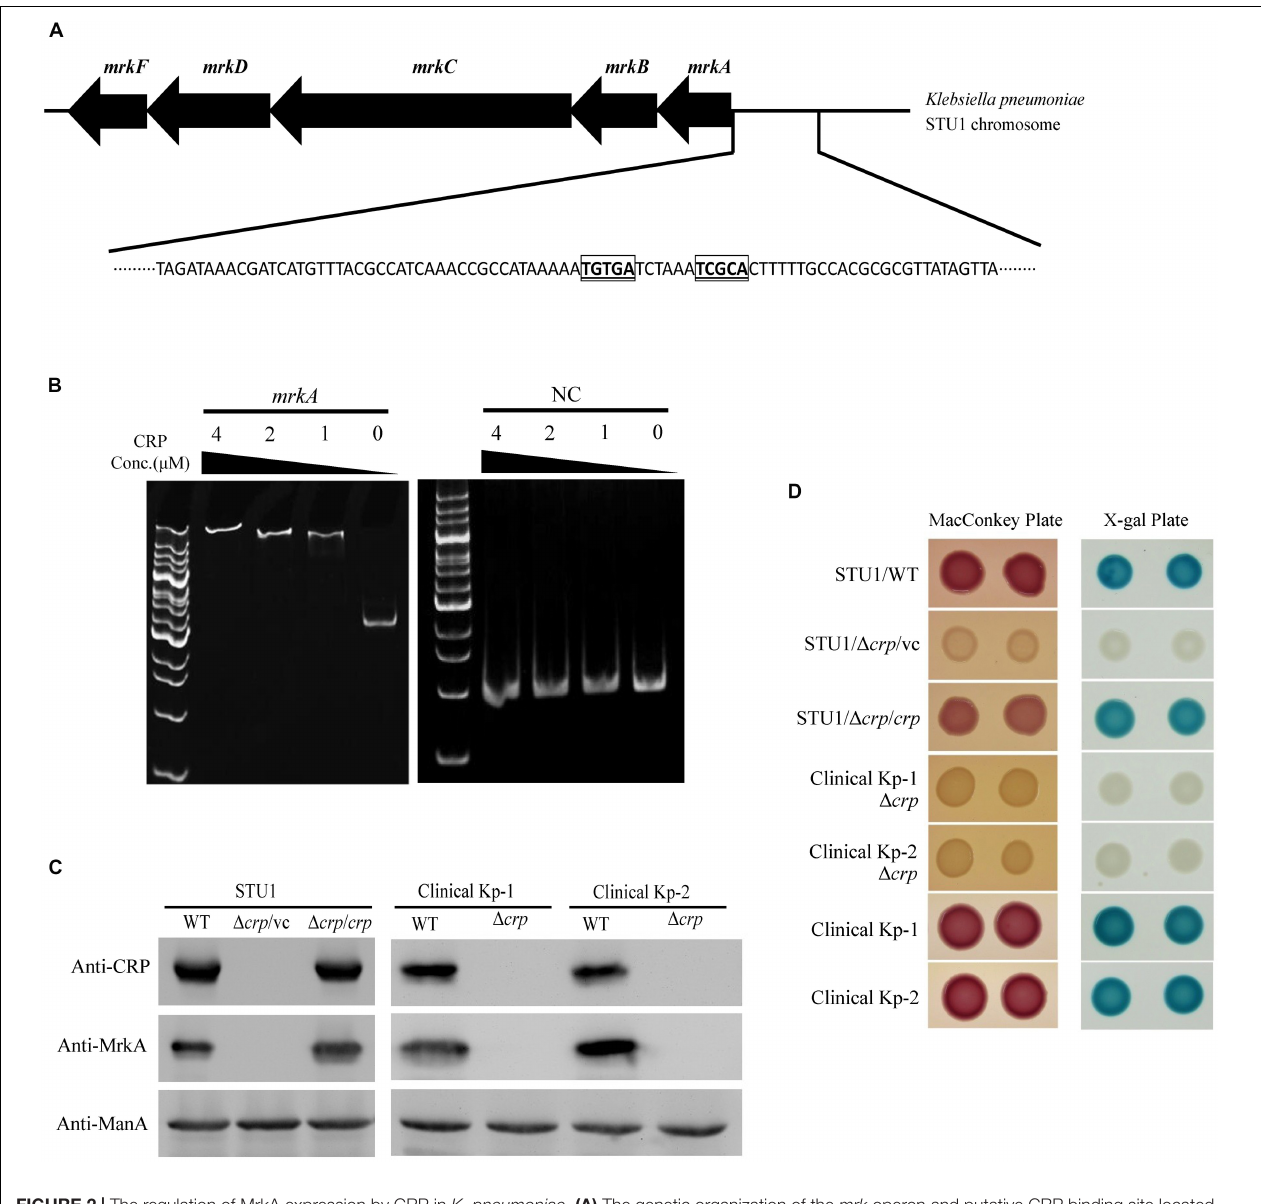
FIGURE 2 | The regulation of MrkA expression by CRP in K. pneumoniae . (A) The genetic organization of the mrk operon and putative CRP binding site located upstream of mrkA . The putative CRP core binding sites are indicated with bolded, underlined and boxed letters. (B) The EMSA demonstrating the interaction of the region upstream of mrkA and CRP. mrkA : a 394-bp DNA fragment containing the mrkA upstream region. NC: a 222-bp DNA fragment containing the EtcA structural region as the negative control. The concentration of purified His-tagged CRP ranged from 4 to 1 µ M. The gel is representative of three independent experiments. (C) Western blot analysis of CRP, MrkA, and ManA expression in K. pneumoniae . ManA was used as the loading control. The blots are representatives of at least three independent experiments. (D) The representative colony phenotypes on MacConkey agar (MacConkey plate) and LB agar containing X-gal (X-gal plate) in three independent experiments. WT, wild-type K. pneumoniae . (cid:49) crp : crp mutant. (cid:49) crp /vc: crp mutant carrying pBAD33 as the vector control. (cid:49) crp/crp : complementation strain of the crp mutant carrying pBAD33::crp. Clinical Kp-1 and Clinical Kp-2 are two clinical K. pneumoniae isolates. The phenotypes of the K. pneumoniae STU1 crp mutant ( (cid:49) crp ) and its corresponding vector control ( (cid:49) crp /vc) were the same, so (cid:49) crp /vc was used to represent of K. pneumoniae STU1 (cid:49) crp in this